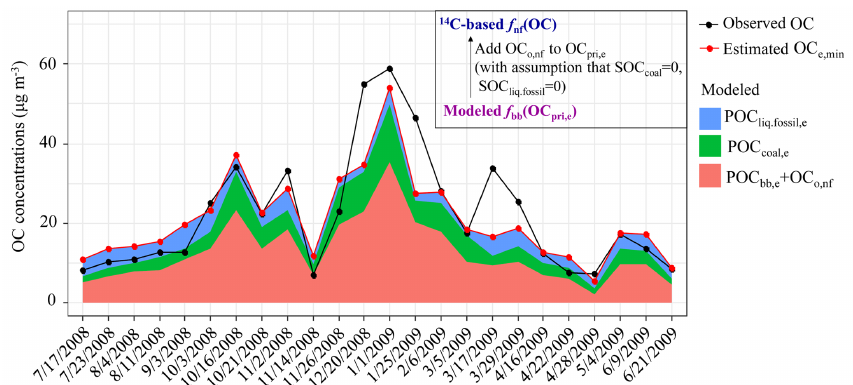
Figure 7. Observed and estimated OC concentrations. Modeled OC e , min is the sum of OC pri , e and OC o , nf . OC o , nf accounts for the differ- ences between f nf (OC) and f bb (OC pri , e ) , with an unrealistic assumption of no secondary fossil OC, leading to minimum addition to OC pri , e . The coral area shows the POC bb , e and OC o , nf , green area the POC coal , e , and blue area the POC liq . fossil , e . Estimation is based on MCMC4 results for EC source apportionment and primary OC / EC ratios corresponding to case (A) in Fig.